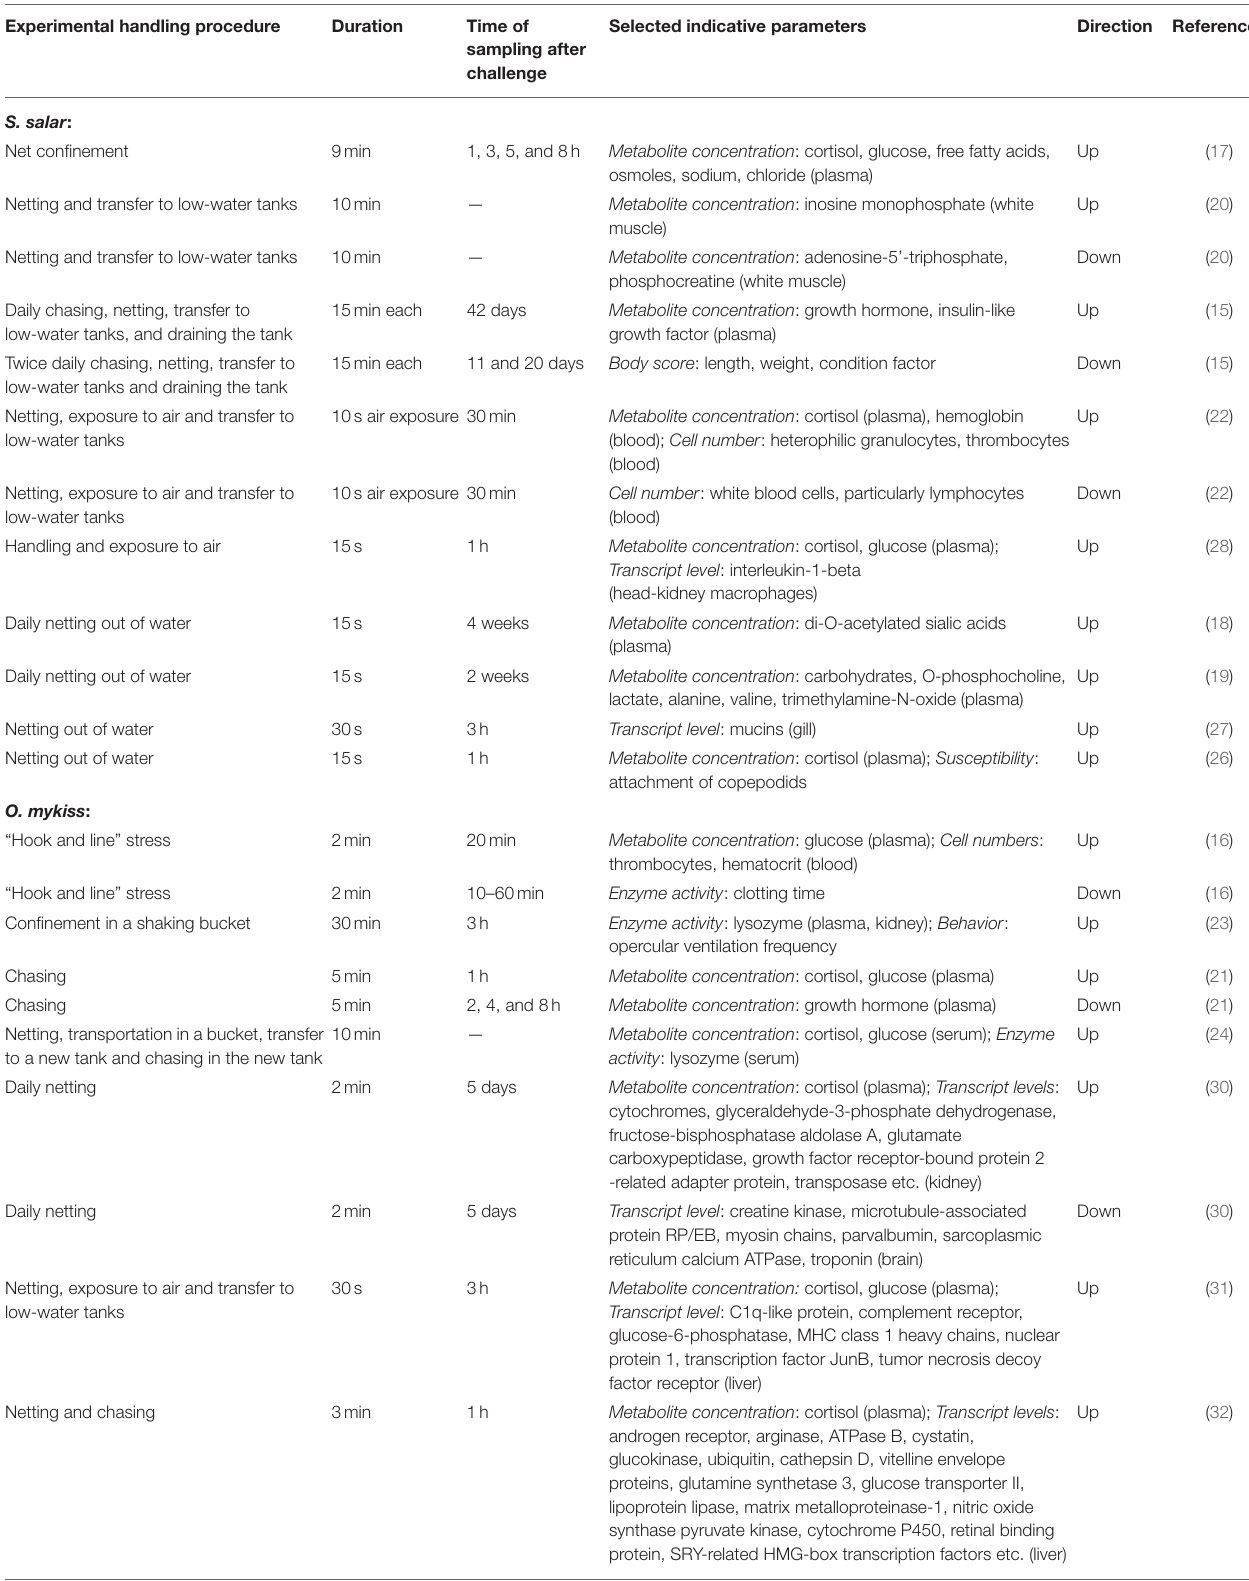
TABLE 1 | Overview about selected physiological parameters altered in response to handling stress in Oncorhynchus mykiss and Salmo salar . Experimental handling procedure Duration Time of Selected indicative parameters Direction sampling after challenge